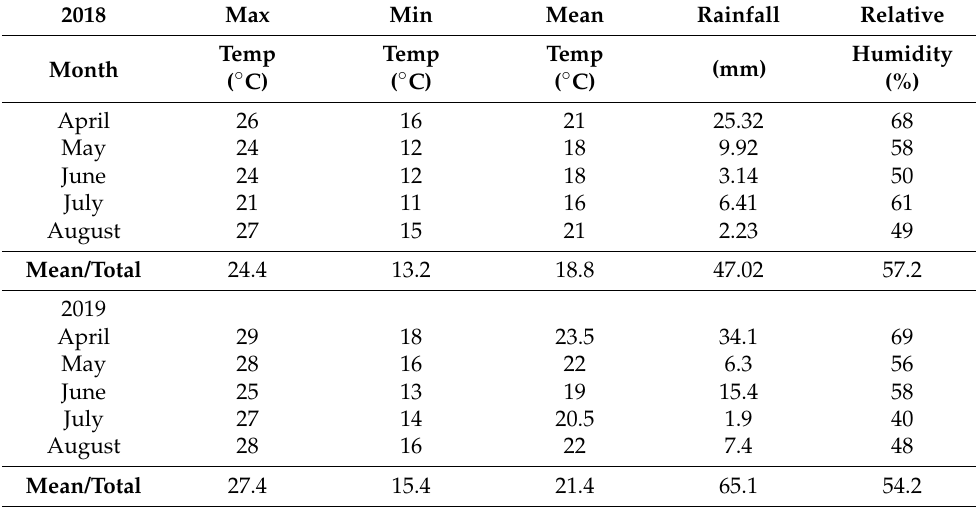
Table 1. Summary of weather during 2018 and 2019 cropping season in